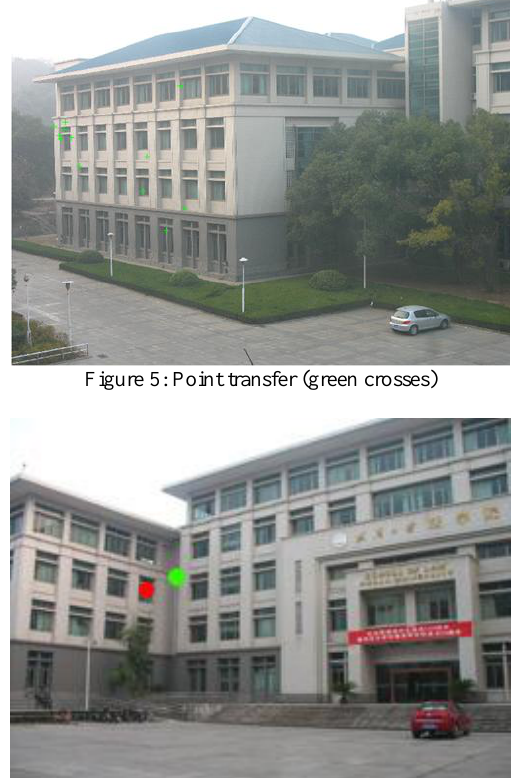
Figure 2: 9 of 24 images used to reconstruct the scene